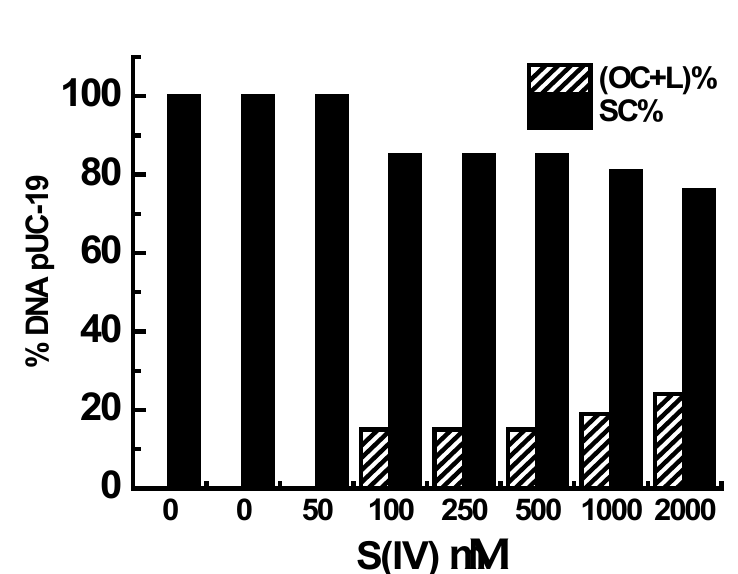
FIGURE 2 – % of (OC + L) and SC configurations of pUC-19 DNA according to the experimental conditions described in Figure 1D (Lanes 1 to